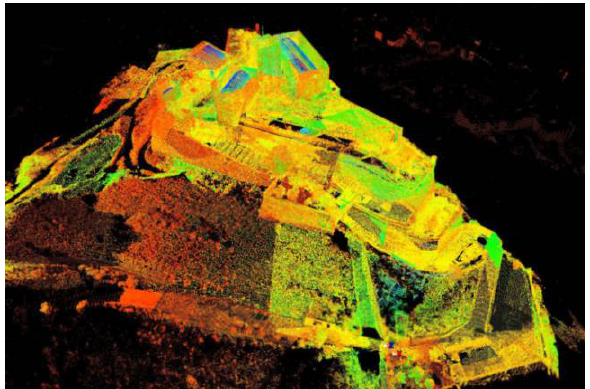
Fig. 7. Scanner-laser survey: Point cloud of the Castle of Monzón (Huesca, Spain)